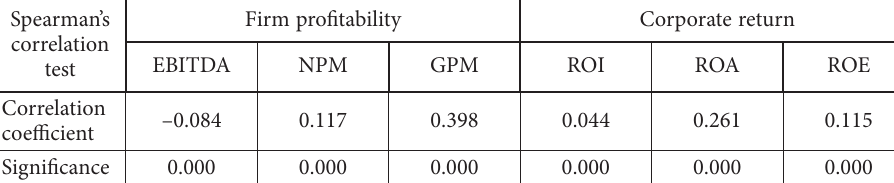
Table 4. Results of correlation test